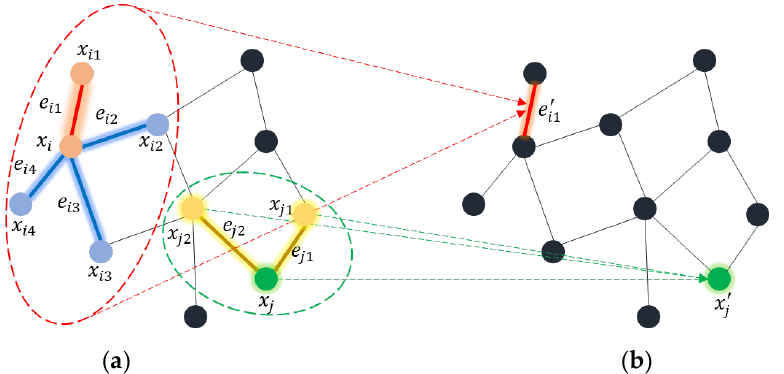
Figure 3. Graph convolution operations: green and red dotted circles represent (a) node and edge convolution operations neighbors on the left side and (b) convolution outputs on the right side. To perform node convolution at node x j in Figure 3a, the weighted average of neigh- boring nodes such as x j 1 and x j 2 is determined as shown in Figure 3b with green